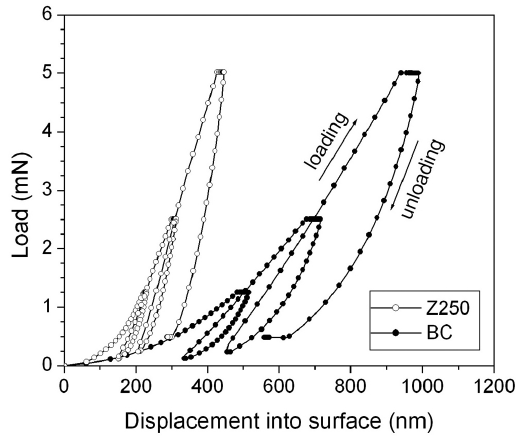
Figure 4. Elastic modulus (E) values obtained from nanoindentation tests as a function of contact depth for the following samples: bare Filtek Z250 ® composite resin (Z250), and Z250 samples filled with Fortify Plus ® (FP), Fortify ® (F), FillGlaze ® (FG) and BisCover ® (BC) sealants. Dashed lines are guides to the